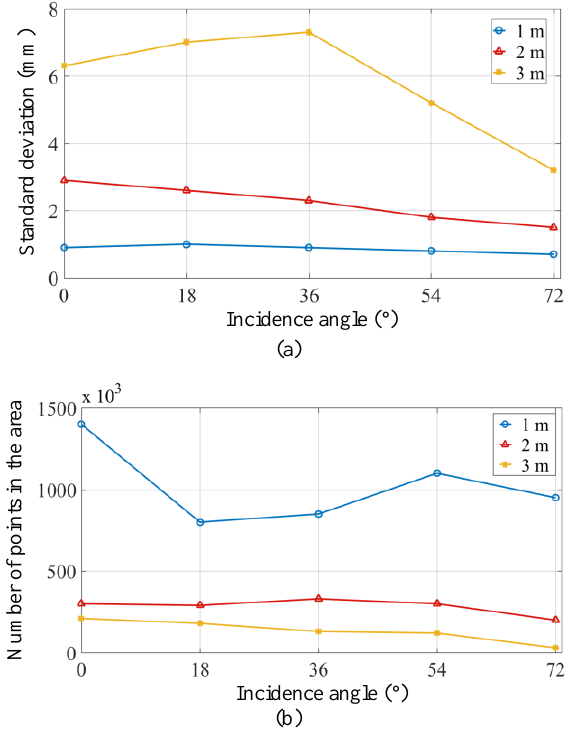
Figure 5. (a) Influence of the incidence angle on the point cloud precision (standard deviation). (b) Variation of the number of points in the considered area depending on the incidence